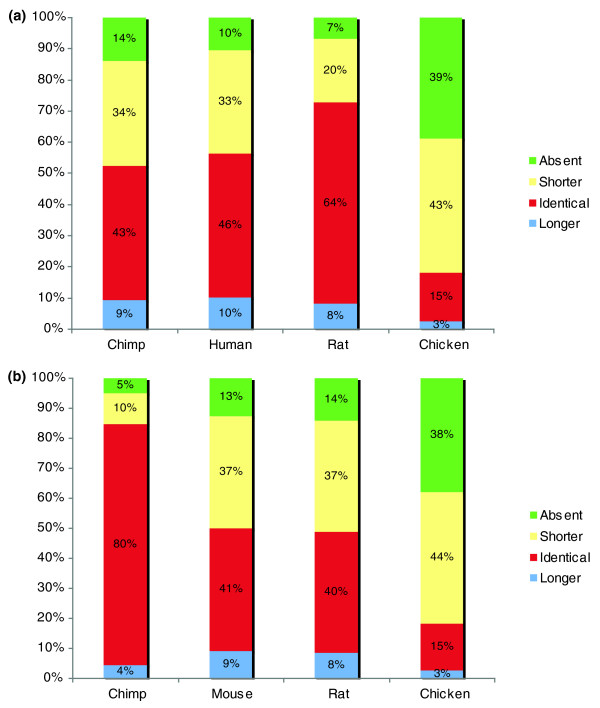
Conservation of tandem AARs from the perspective of the human and mouse protein sets. (a) Vertical bars represent proportions of tandem repeats that are absent (light blue), shorter in the target species (yellow), identical in the target species (red) or longer in the target species (purple). Target species (that is, species tested for presence or absence of human repeats) are ordered by phylogenetic closeness to human. (b) Corresponding plot for mouse repeats.